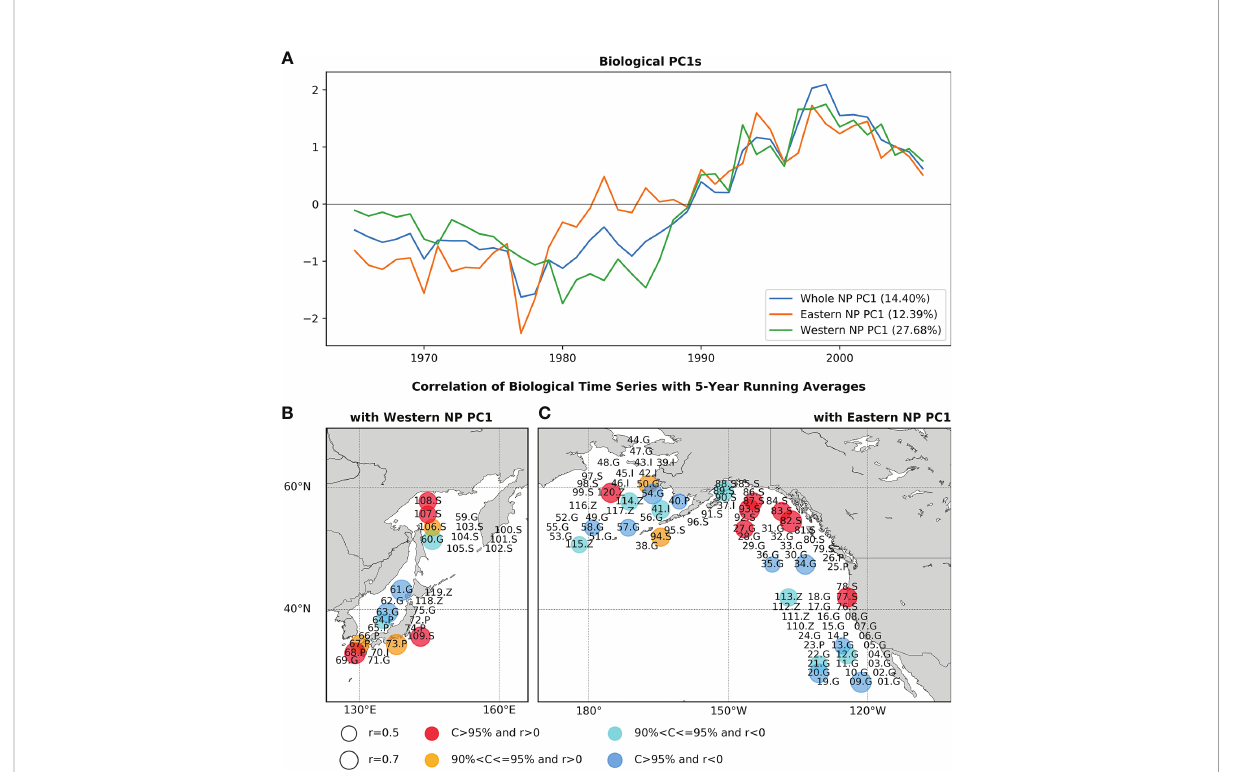
FIGURE 1 (A) The fi rst Principal Components (PC1s) for the whole North Paci fi c (NP), eastern NP and western NP marine biological time series, and statistically signi fi cant correlations of marine biological time series (B) with the western NP PC1, (C) with the eastern NP PC1. Before calculating correlations 5-year running means are applied to PC1s and marine biological time series. In (B, C) , numbers indicate species ID in Table 1 of Yati et al., while S, G, P, Z and I indicate salmon, ground fi sh, small-pelagic, zooplankton and invertebrate, respectively. Circle size indicates the absolute values of correlations and colors of the circles (red, orange, cyan, blue) indicate the sign of correlations and the corresponding con fi dence levels. (After Yati et